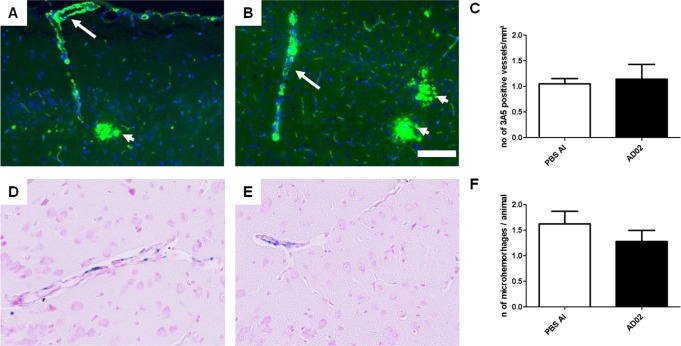
Cerebral amyloid angiopathy and microhemorrhaging are unchanged following AFFITOPE-immunization.The analysis of the incidence of amyloid bearing vessel in AFFITOPE- and control treated animals by assessing 3A5 staining in cerebral vessels reveals no significant differences (A-C). A) Example from a cortical section of a control animal. B) Example from a cortical section of an AD02-treated animal. C) Quantitative analysis demonstrating the average number of 3A5 positive vessels/mm² (avg. +/- SEM) in control (n = 9), and AD02-treated animals (n = 8). The analysis of the incidence of cerebral micro-hemorrhages in these animals by assessing Hemosiderin staining (= Prussian Blue) did not show significant differences at 14 months of age (D-F). D) Example from a cortical section of a control animal. E) Example from a cortical section of an AD02-treated animal. F) quantitative analysis demonstrating the average number of Hemosiderin positive vessels/animal in control (n = 9), and AD02 treated animals (n = 8, respectively); Arrows indicate 3A5 positive vessels, arrowheads indicate amyloid deposits. Scale bar: 50µm; pictures taken at 20x magnification